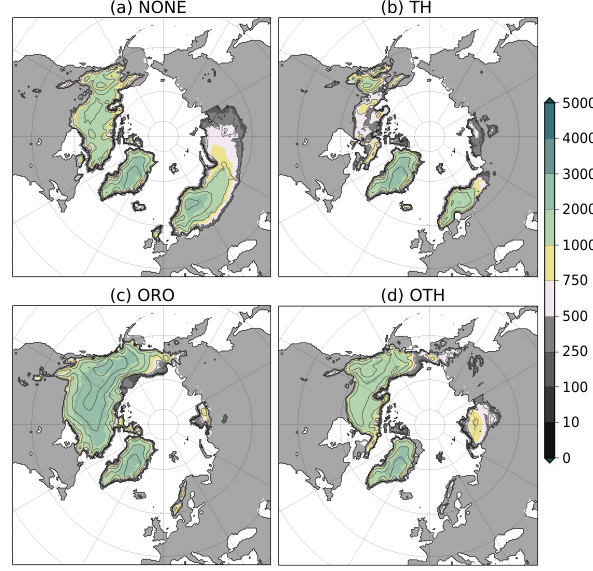
Fig. 3. Ice thickness (colors) and ice-sheet height (con- tours, isolines every 500m) simulated at 115ka with the four parameterizations